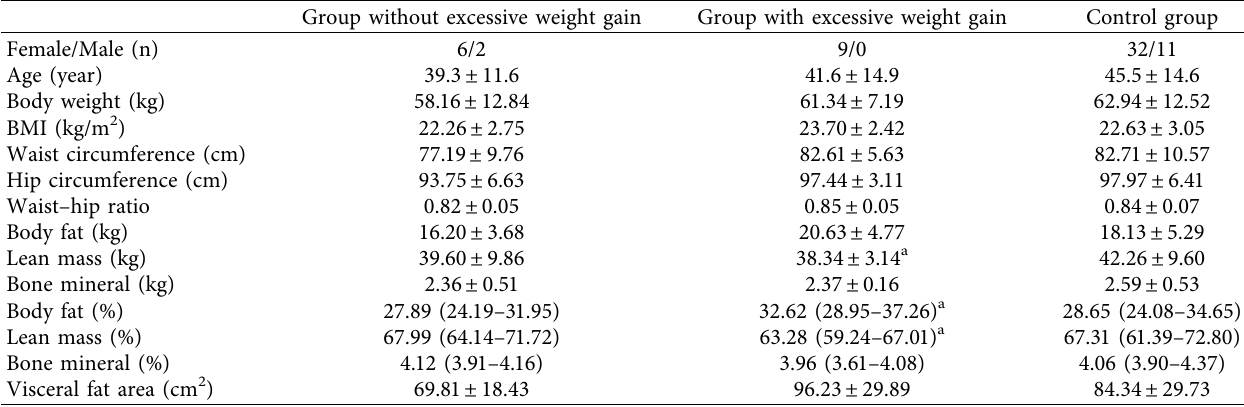
Table 4: Comparison of anthropometric and body composition parameters between patients at the euthyroid state and euthyroid controls. Group without excessive weight gain Group with excessive weight gain Control